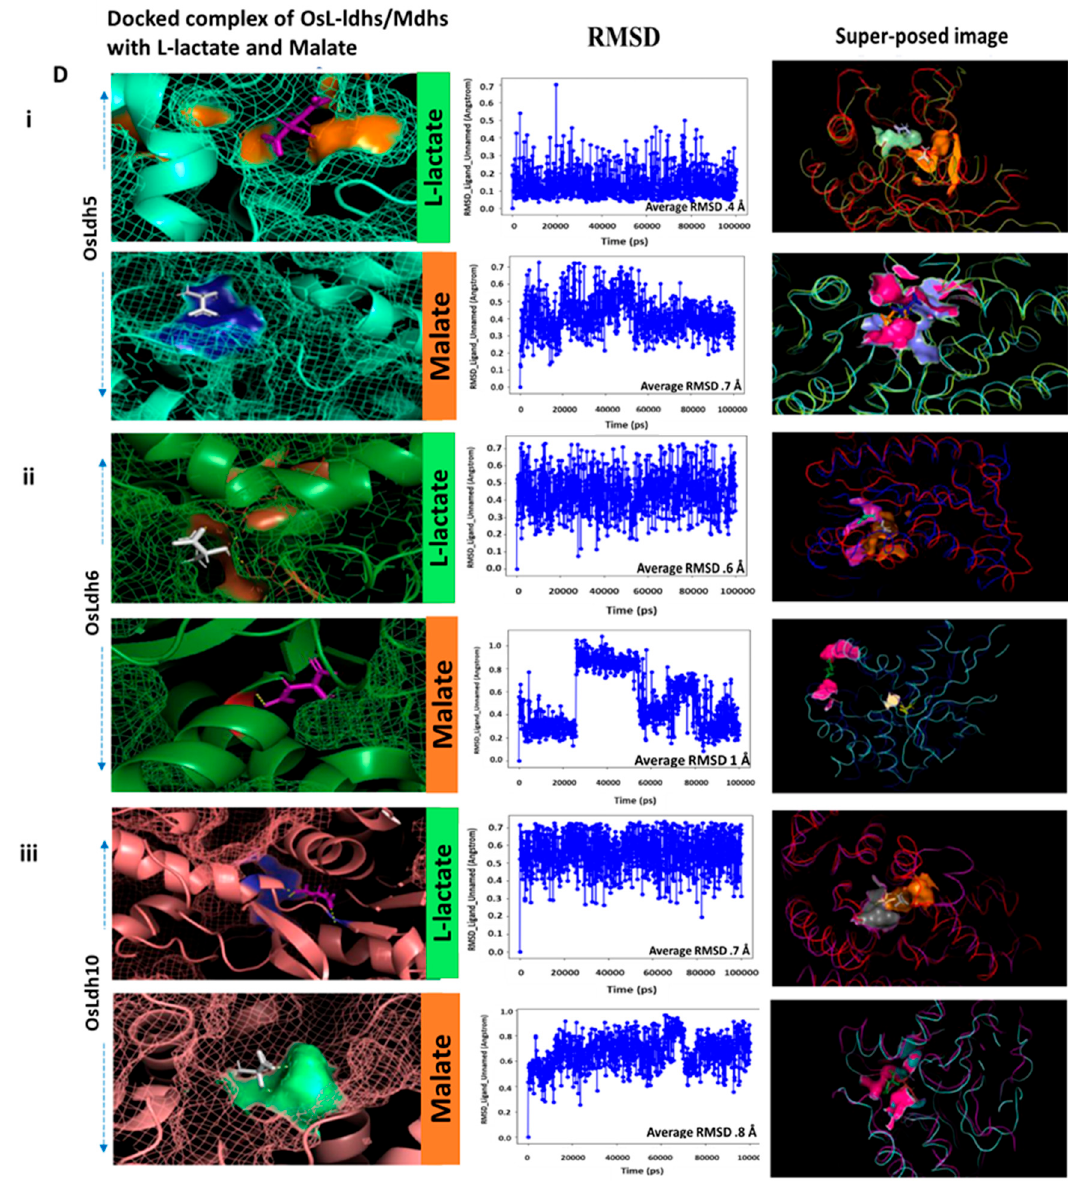
Figure 7. ( A ) Consolidated colour plot for docked complex of AtLdh1 and AtLdh4 proteins. ( i ) AtLdh4 docked with L-lactate and malate. ( ii ) AtLdh1 docked with L-lactate and malate. The RMSD graphs of each of the proteins have also been plotted. Y-axis denotes RMSD value (Å) and X-axis denotes time (ps). The ligands, L-lactate (green) and malate (orange), have been depicted with colour strips on the right side of the figures. Docking has been carried out using Schrodinger Suite. The average RMSD value has been mentioned in each of the graphs. ( B ) Putatively functional L-lactate dehydrogenases in rice . ( i ) OsLdh3, ( ii ) OsLdh7 and ( iii ) OsLdh9 docked with L-lactate (green) and malate (orange). The RMSD graph of each of the proteins have also been plotted. ( C ) Putatively functional malate dehydrogenases in rice . ( i ) OsLdh1, ( ii ) OsLdh2 ( iii ) OsLdh4, ( iv ) OsLdh8, ( v ) OsLdh11 and ( vi ) OsLdh12 docked with L-lactate (green) and malate (orange). The RMSD graphs of each of the proteins have also been plotted and depicted. Y-axis denotes RMSD value (Å) and X-axis denotes time (ps). Docking has been carried out using Schrodinger Suite. The average RMSD value has been mentioned in each of the graphs. ( D ) Putatively functional malate/L-lactate dehydrogenases in rice . ( i ) OsLdh5, ( ii ) OsLdh6 and ( iii ) OsLdh10 docked with L-lactate (green) and malate (orange). The RMSD graphs of each of the proteins have also been plotted. Y-axis denotes RMSD value (Å) and X-axis denotes time (ps). The respective proteins were super-posed with the enzymatically active AtLdh1 (cyan blue) and